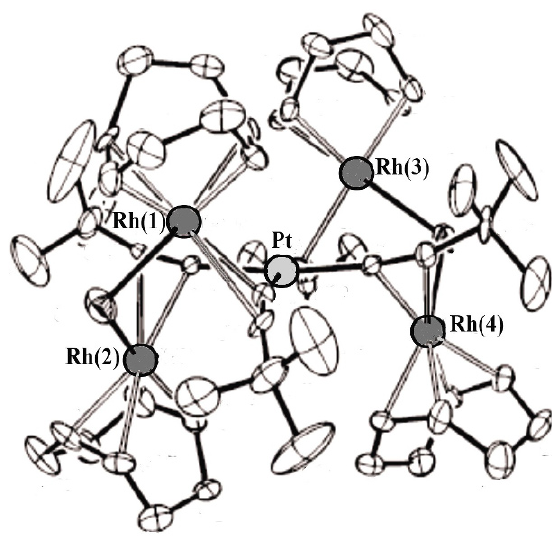
Figure 5. Structure of [Pt(µ-C ≡ CBu t )